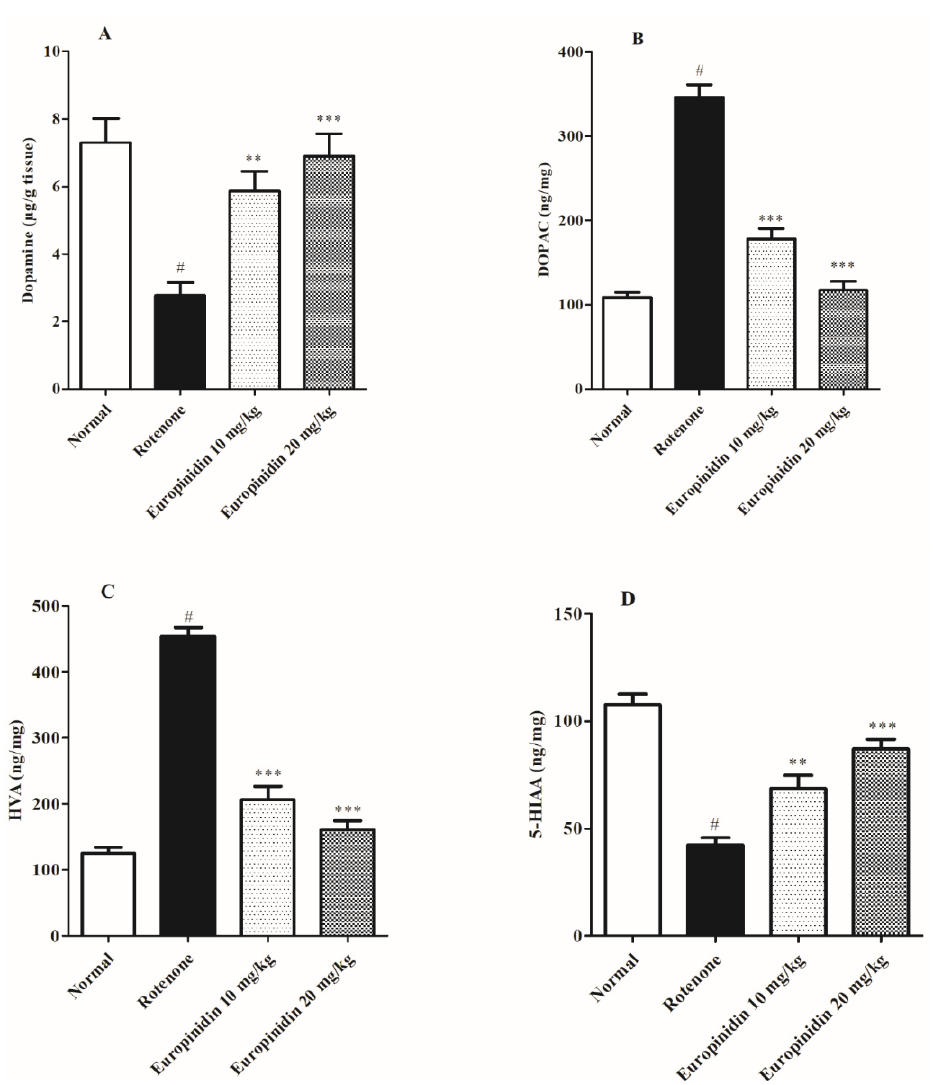
Figure 4. Effect of europinidin on neurotransmitter levels. ( A ) Dopamine, ( B ) DOPAC, ( C ) HVA concentrations, ( D ) 5-HIAA concentrations. The data were expressed as mean ± S.E.M. ( n = 6/group). ** p < 0.01, *** p < 0.001 when compared with the control group; # p < 0.001 when compared with the rotenone group (one-way ANOVA followed by Tukey’s